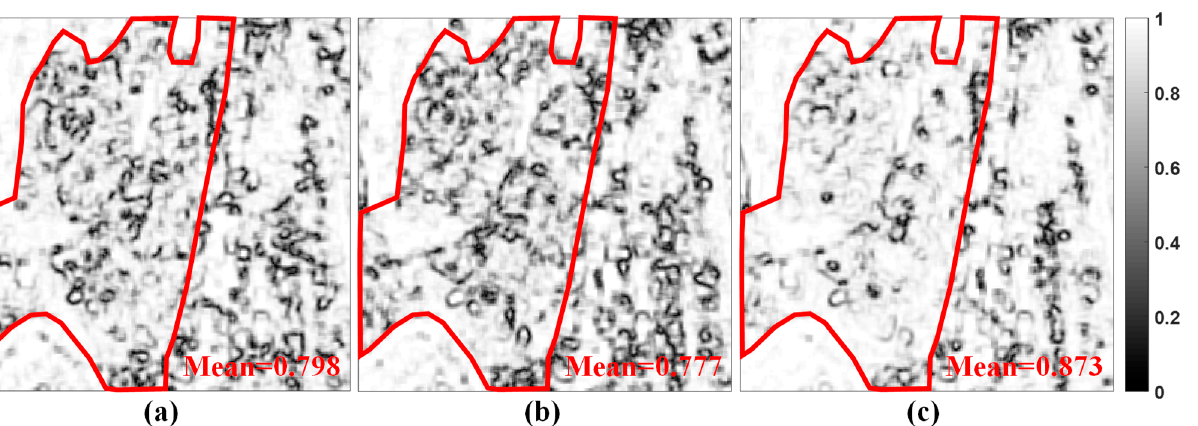
Figure 12. Estimated TPC images of ROI (250 × 250 pixels) using ( a ) HH, ( b ) ESPO, and ( c ) proposed TSTP methods. The estimated TPC means over the natural scene are shown in Figure 12. The lowly coherent natural area is marked by the red irregular box in Figure 12a–c. In terms of phase quality, the polarimetric optimization capability of the ESPO method is unsatisfactory, especially in the marked natural scene in Figures 11 and 12. The SPC level is lower than that of the HH method even though the TPC level is slightly higher than that of the HH method. Hence, in terms of the SPC level based on the interferogram between the 9th and 1st acquisitions, the numerical ranking of the mean values is TSTP > HH > ESPO. In terms of the TPC level based on the optimized ESM phases, the numerical ranking of the mean values is TSTP > ESPO > HH. Additionally, we make the coherence- based histogram statistics over the selected natural scene in Figure 13, including the SPC and TPC histograms. Among all methods, the proposed TSTP method achieves the high- est coherence level.